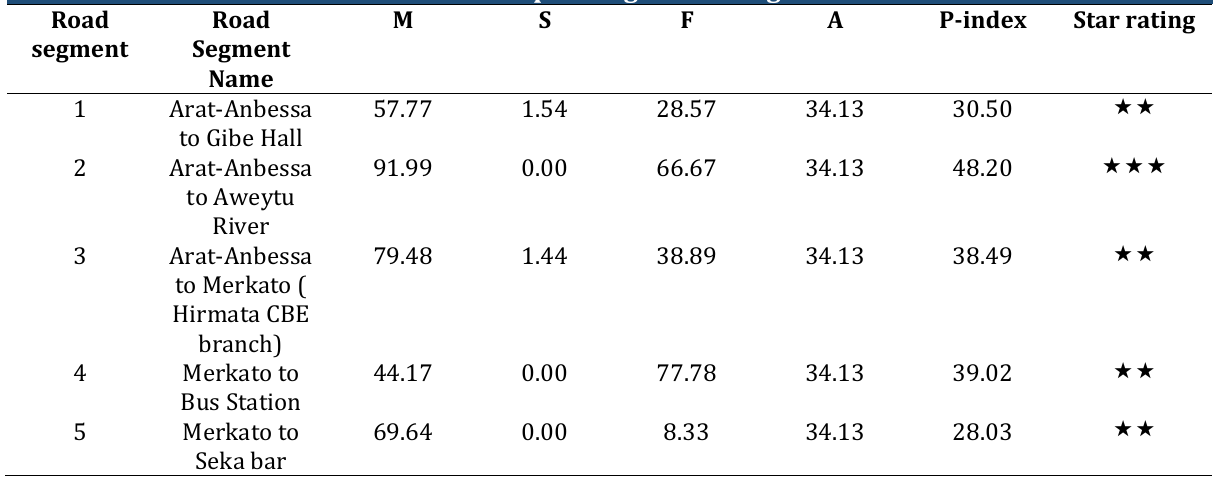
Table 8: Values of P-index with the corresponding star-rating Road